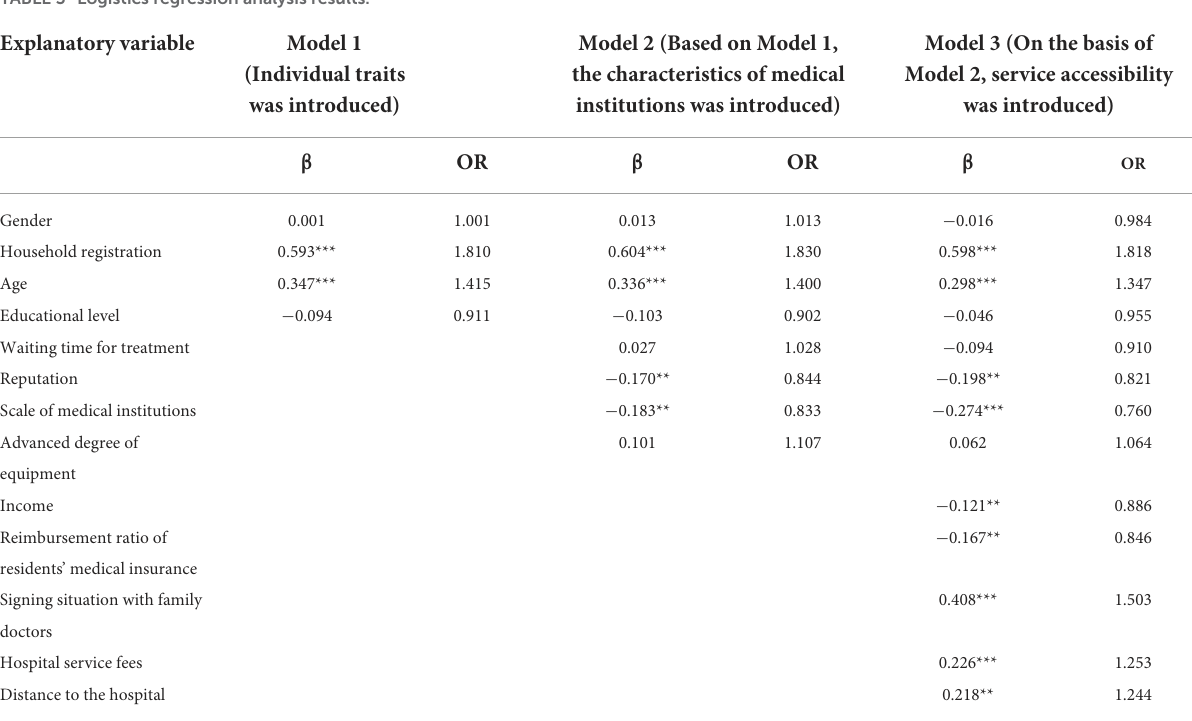
TABLE 3 Logistics regression analysis